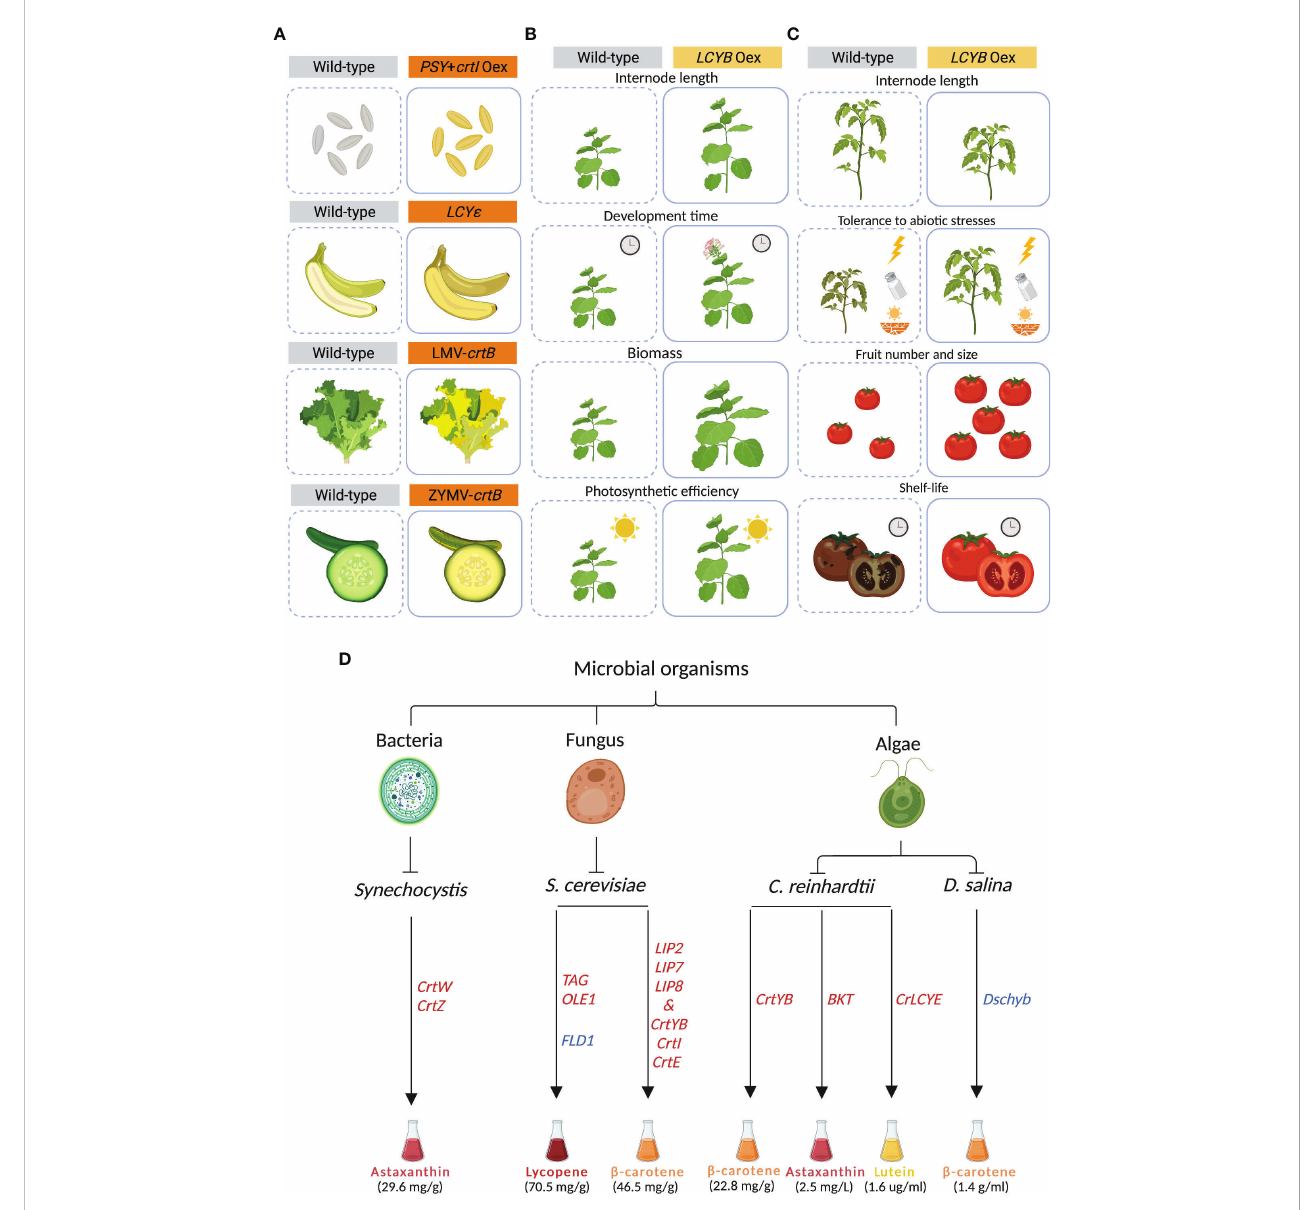
FIGURE 2 Synthetic carotenoid biosynthesis in plants and microorganisms. (A) Golden Rice was generated by co-expressing the phytoene synthase ( PSY ) and the bacterial crtI in the carotenoid-free rice endosperm. In Cavendish banana, lycopene epsilon-cyclase ( LCYE ), was mutated, leading to an increase in b - carotene. In lettuce ( Lactuca sativa ) and zucchini ( Cucurbita pepo ), the virus-mediated overexpression of the bacterial crtB resulted in carotenoid accumulation in leaves and fruits, respectively. (B) The overexpression of lycopene- b -cyclase ( LCYB ) gene in tobacco ( Nicotiana tabacum cv. Xanthi) resulted in increased internode length, accelerated development and fl owering time, and enhanced plant biomass and photosynthetic ef fi ciency. (C) The overexpression of lycopene- b -cyclase ( LCYB ) gene in different cultivars of tomato ( Solanum lycopersicum ) altered internode length, and increased tolerance to abiotic stresses, number and size of fruits, and fruit shelf-life. (D) Different strategies for carotenoid mass production in Synechocystis , Yarrowia lipolytica , Saccharomyces cerevisiae , Chlamydomonas reinhardtii , and Dunaliella salina . Overexpressed and suppressed genes are depicted in red and blue, respectively. Figure was designed in